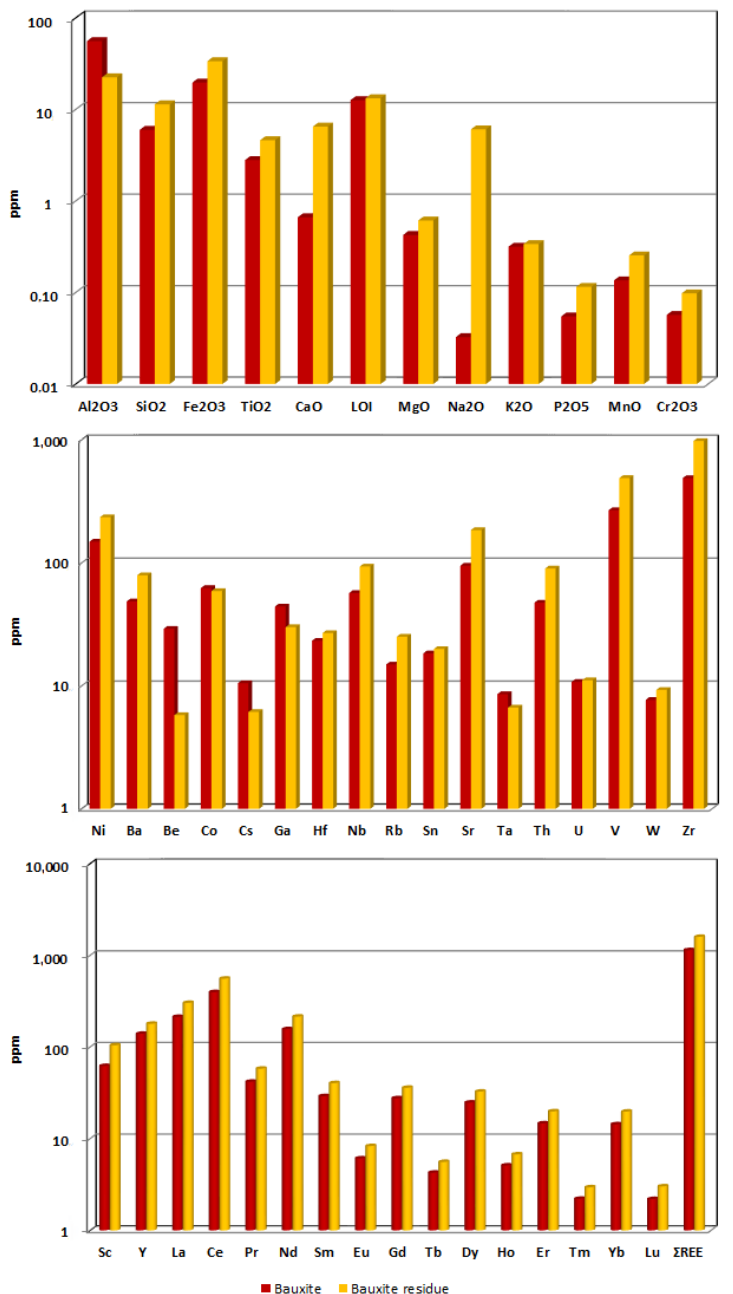
Figure 19. Content comparison of analysed oxides, microelements and rare earth elements in bauxites and bauxite residue. Based on data: (Radusinovi´c [5] and REEBAUX [6]); Bauxite mines—Nikši´c and Aluminium factory—Podgorica (KAP).